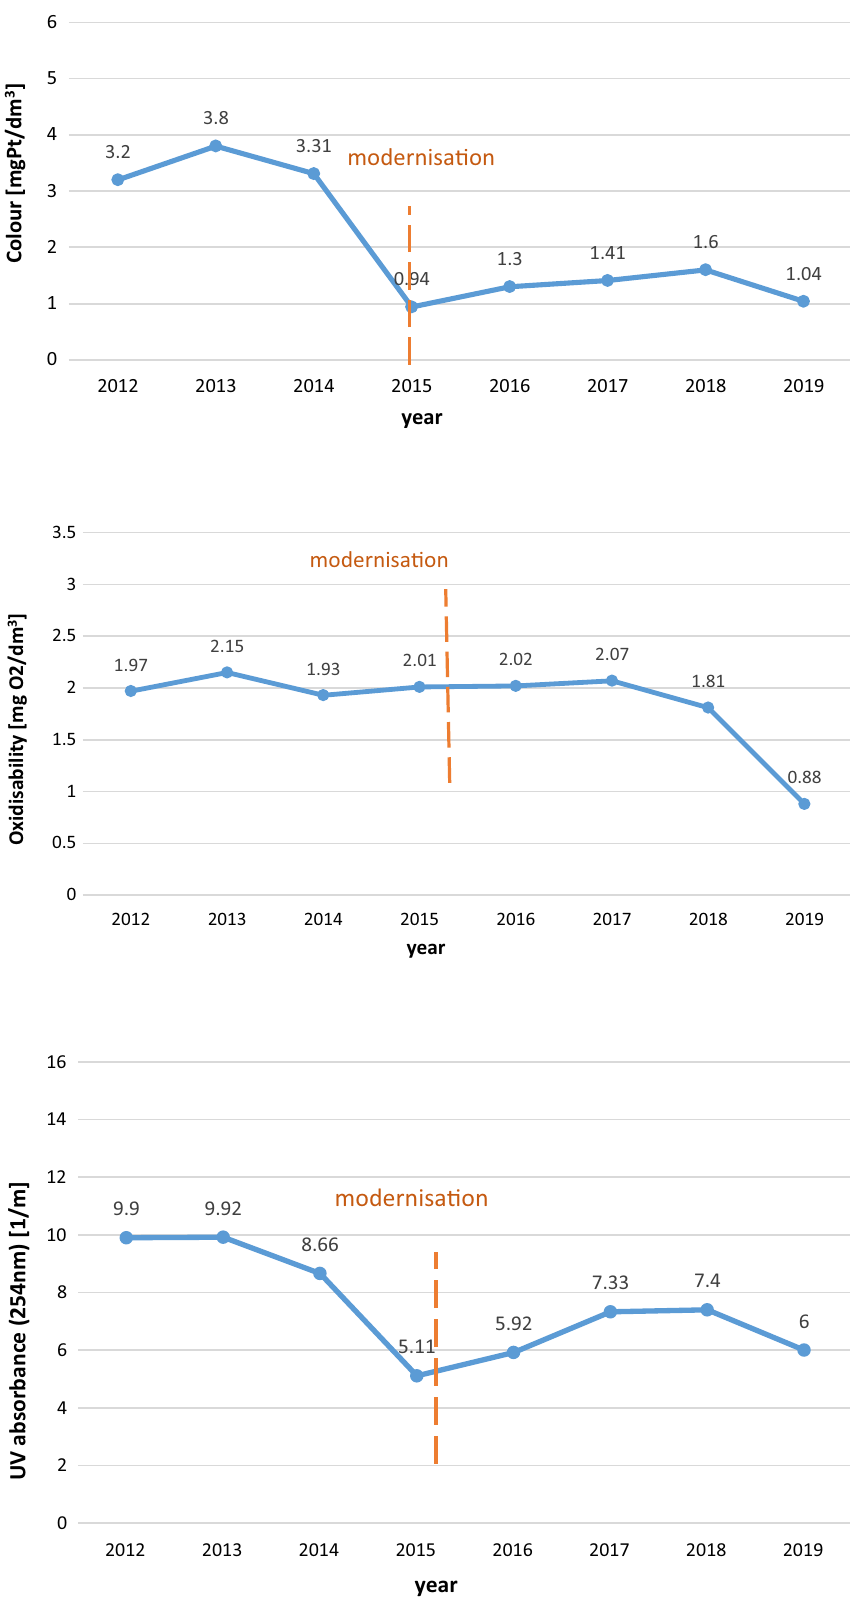
Fig. 3 Average colour of treated